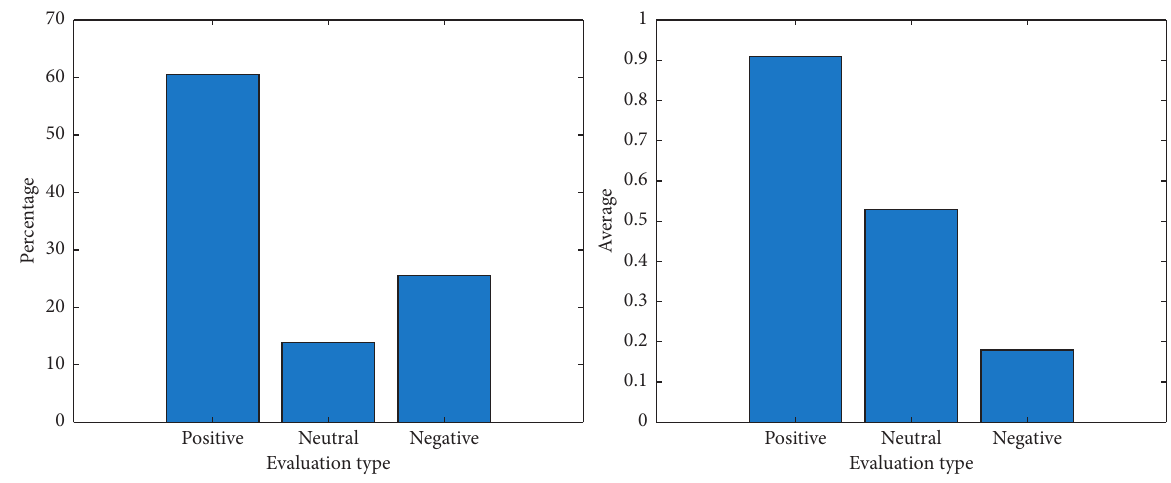
Figure 4: Image evaluation type.